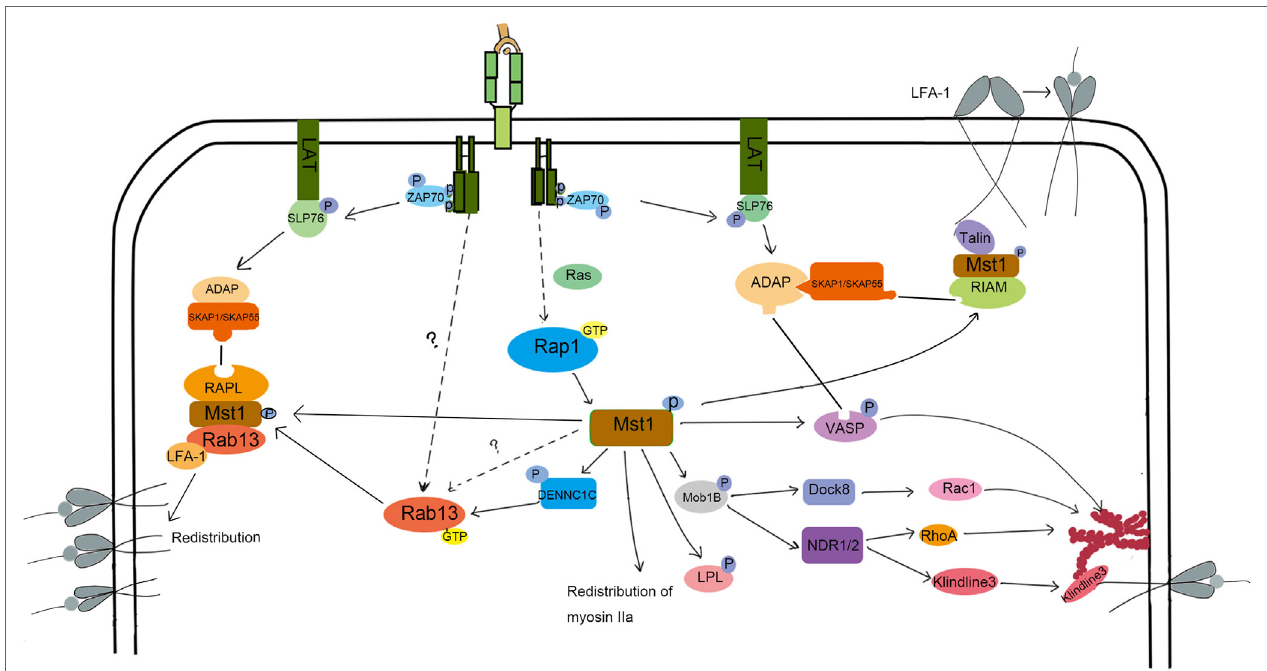
FiGURe 2 | The molecular mechanism of Mst1 regulating the activation and redistribution of LFA-1 and migration. To induce LFA-1 activation and clustering, S1P and CCL21 or TCR signaling activate Mst1 through Rap1. Activated Mst1 then forms a complex with RIAM and Talin and associates with ADAP/SKAP1 to induce LFA-1 activation. Kinlin-3 is also activated during this process and re-distributes to the inner pSMAC, where it interacts with LFA-1 and cytoskeleton to promote the stability of IS. Besides, Mst1 activates Rab13 and forms a RAPL/Mst1/Rab13/LFA-1 complex, directing the LFA-1 redistribution to the ADAP/SKAP1 site. Chemoattract-induced signals also activate Mst1 to induce the phosphorylation of Mob1B, LPL, and VASP to regulate the polymerization of F-actin and cell morphology change, migration, and TCR signal